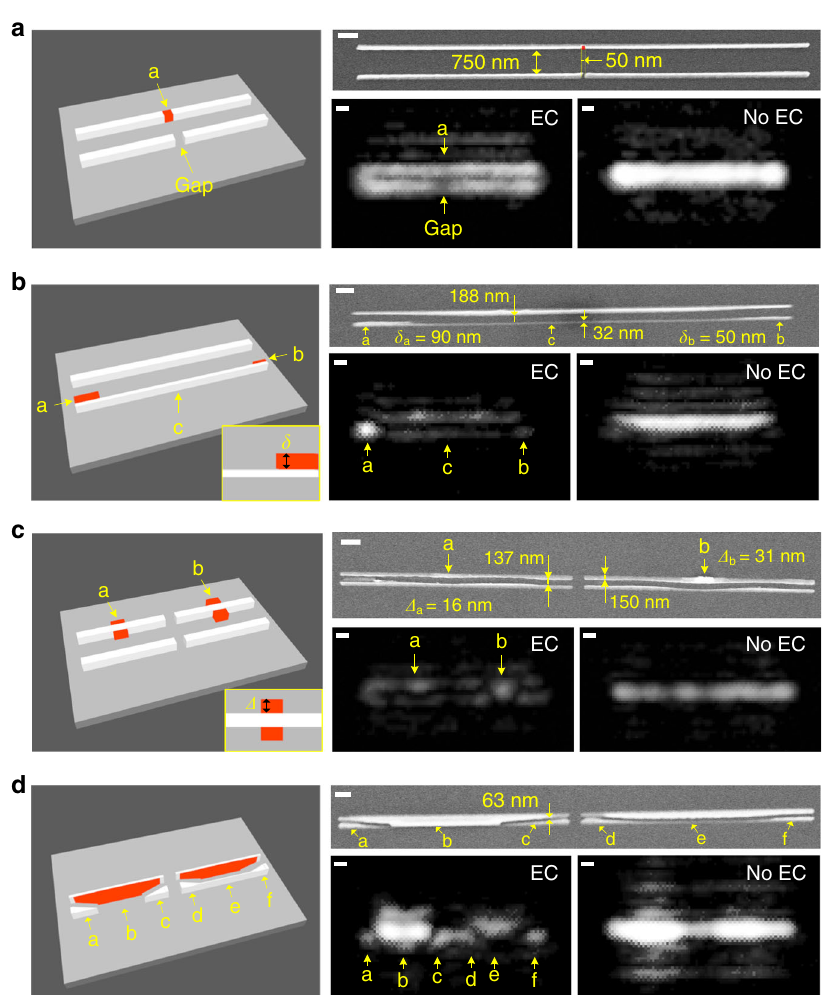
Fig. 5 Experimental imaging for diverse objects. a – d Experimental images of patterns with various objects for the anti-symmetrically excited (EC) and symmetrically excited (no EC) cases. All of the gaps in a – d are smaller than Abbe ’ s 981-nm resolution limit (actual bright fi eld resolution is 4 μ m because of noise) of the top-down microscope. Objects are marked in red in a – d . The scale bars in both the SEM images and the optical images in a – d are 500 nm. The nominal width of the nanowires is 50 3D schematic of Fig. 5c. Similar to those in Fig. 5a and b, one can fi nd two bright spots with the brighter one corresponding to the larger object ( Δ b = 31 nm) in only the EC optical image. A more complicated quad-nanowire structure, shown in Fig. 5d, has tilted 63-nm gaps and two central bumps that break the fi eld symmetry.